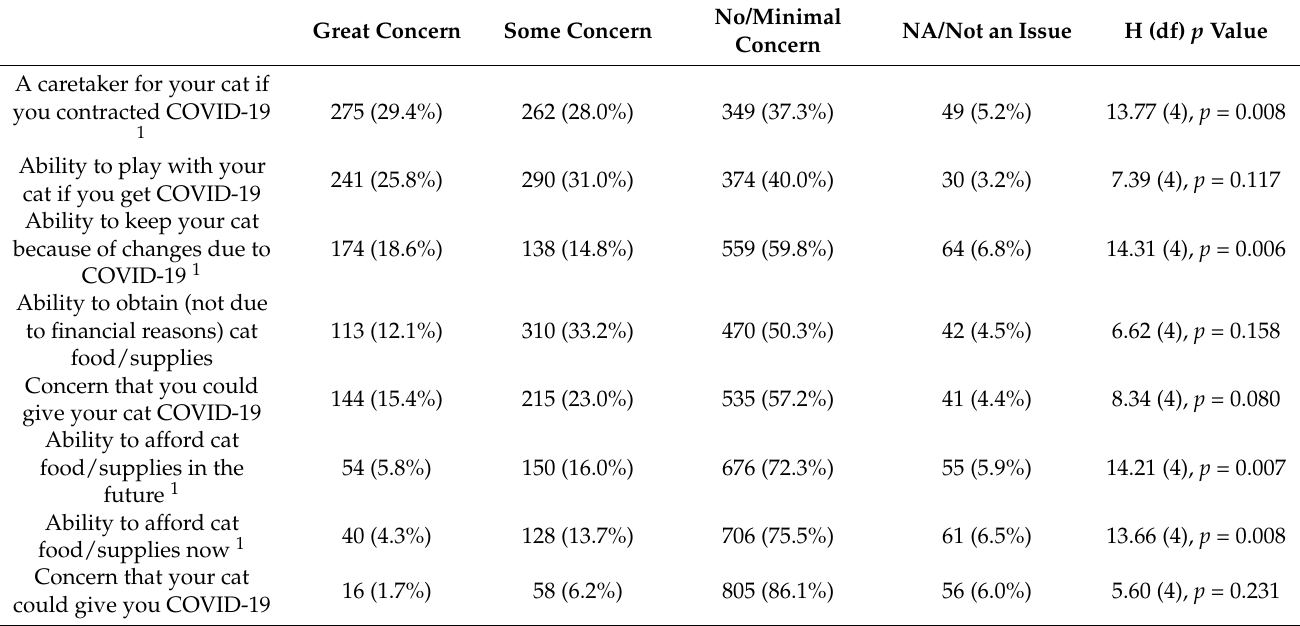
Table 3. Stated concern for non-veterinary cat issues and impact of age.